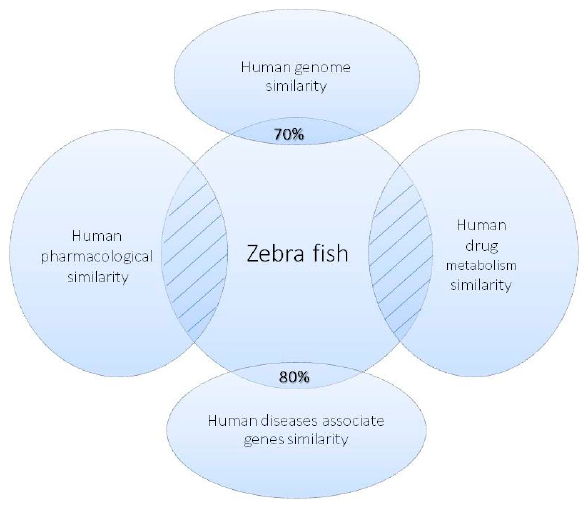
Figure 1. Zebrafish as a relevant model for human disease and cancer therapy. The zebrafish genome shows up to 80% similarity with human disease-associated genes. Moreover, thanks to a well-conserved physiology, the pharmacological behavior and metabolism of several drugs have been screened in zebrafish with effects similar to humans.